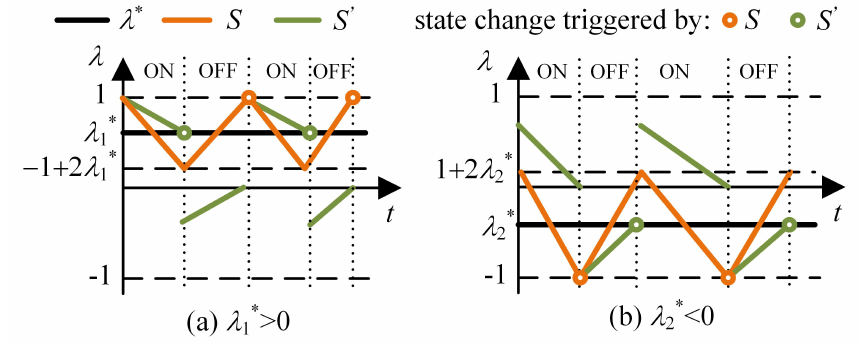
Figure 4. S and S (cid:48) of a DP-GES at different values of λ ∗